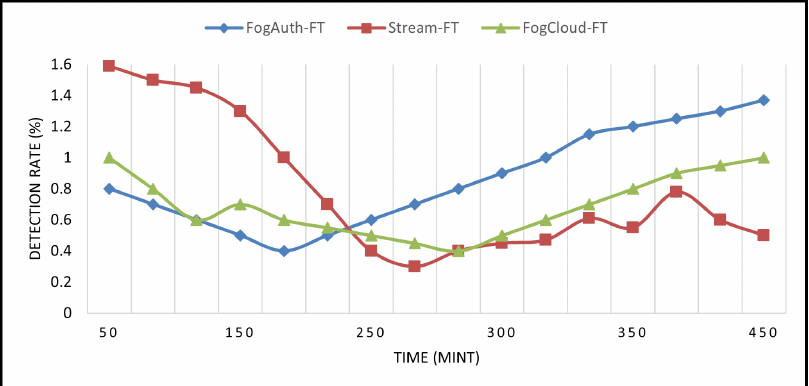
Figure 12. Robustness evaluation against the modification